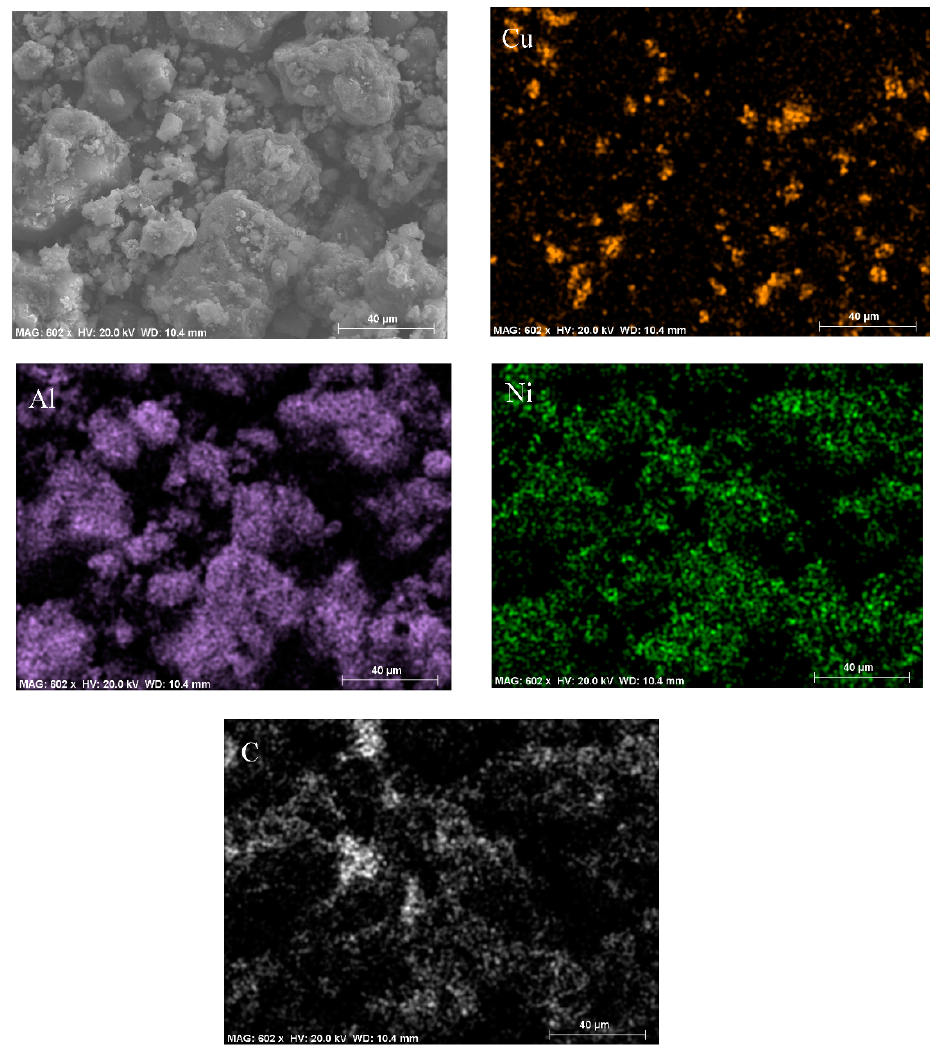
Figure 13. SEM and EDX mapping of 18 wt. % Ni 0.5 -Cu 0.5 / γ -Al 2 O 3 catalyst after durability testing for 30 h at 550 °C, N 2 = 15 cm 3 /min; iso ‐ octane feed rate was 0.03 g/min; S/C molar ratio: 0.9.